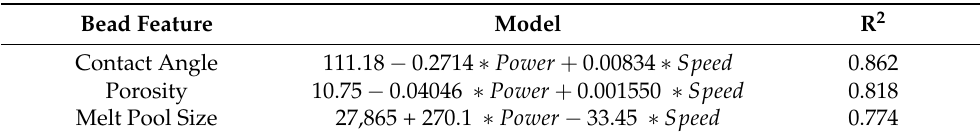
Table 5. Regression model to predict bead features.